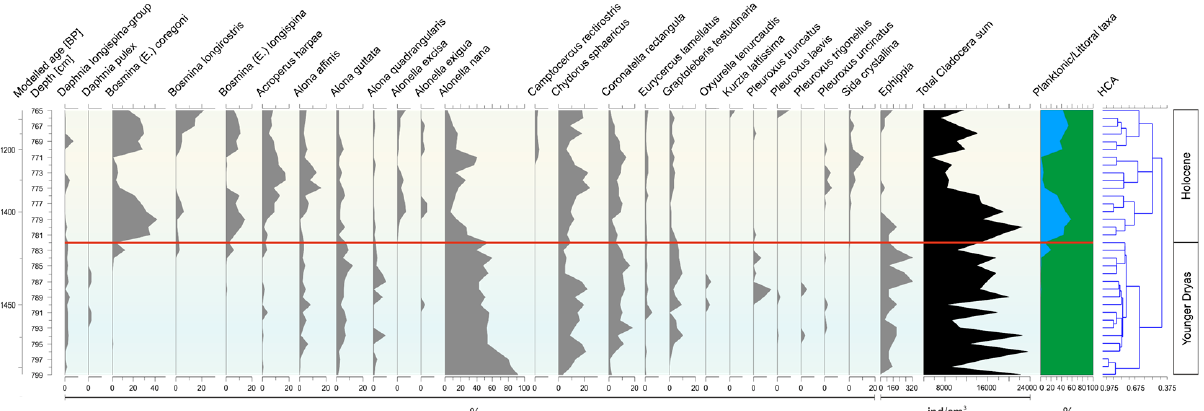
Figure 5. Diagram of percentage composition and the total sum of Cladocera specimens in sediments of the core Z ‐ 3 determined for Younger Dryas/Holocene transition. HCA: Hierarchical Cluster Analysis.